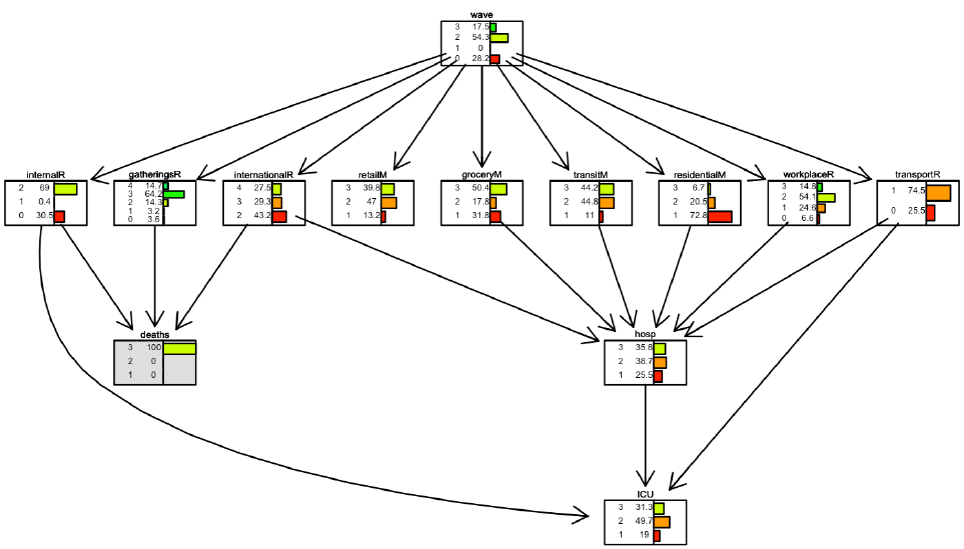
Figure 23. Scenario for Israel when daily deaths are more than 20 (level 3). The deaths node is highlighted in